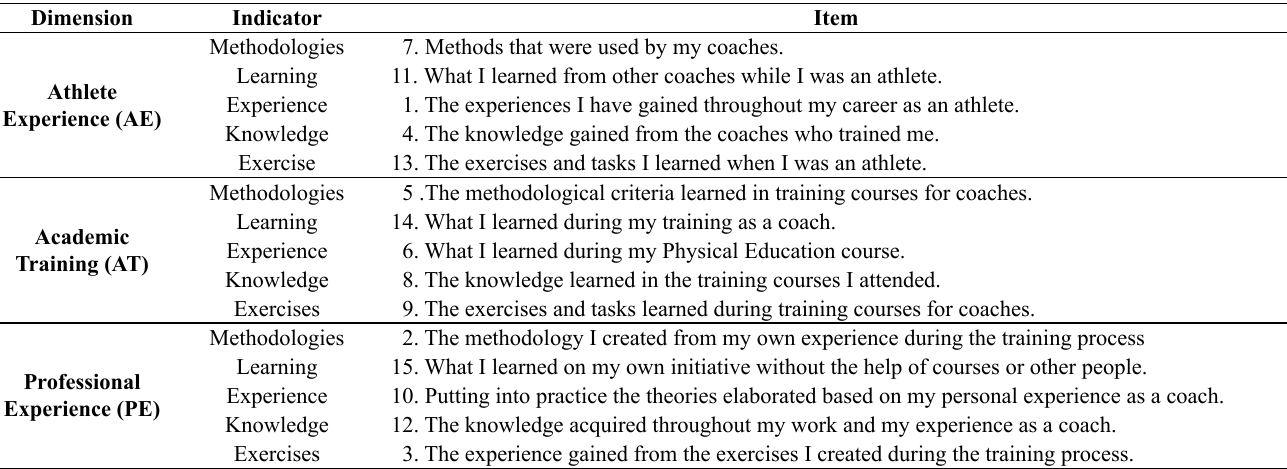
Figure 1. Analytical matrix containing the dimensions, indicators, and QPFT